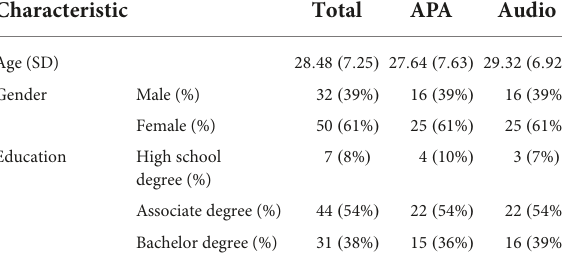
TABLE 1 Demographic characteristics of